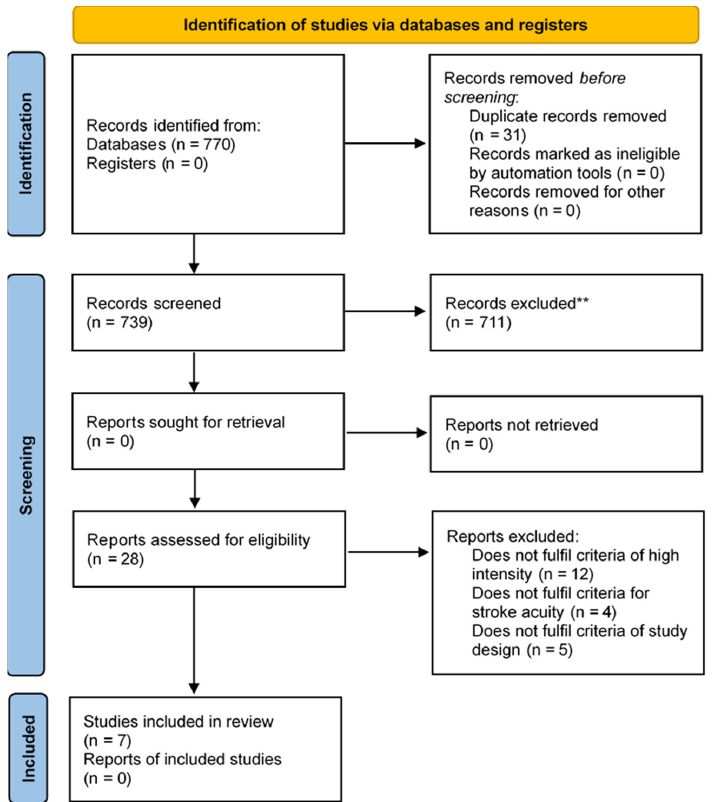
Figure 1. PRISMA flow diagram of study selection process. A total of seven RCTs fulfilled the selection criteria and were included in this review (adapted from Page et al. [30]).